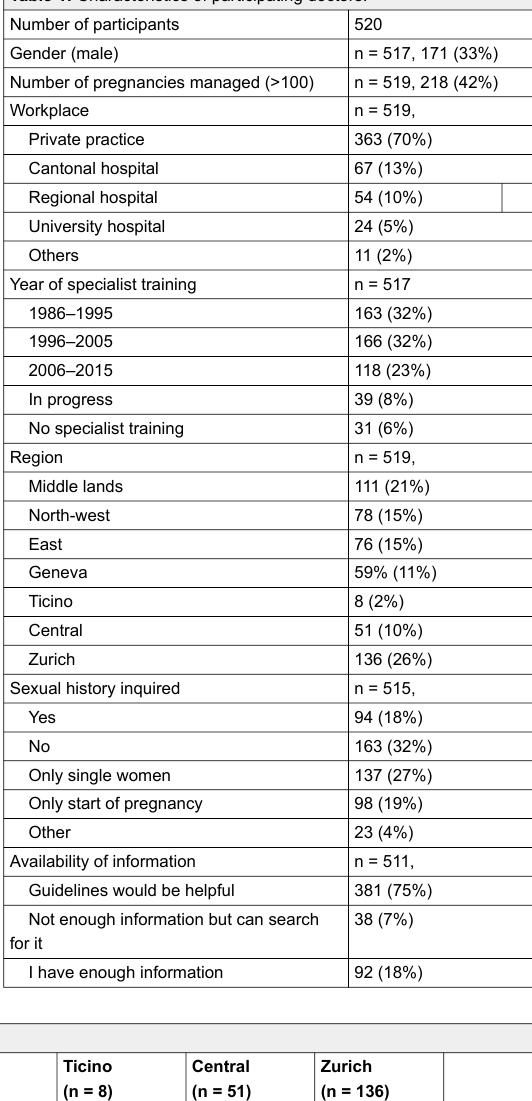
Table 1: Characteristics of participating doctors.